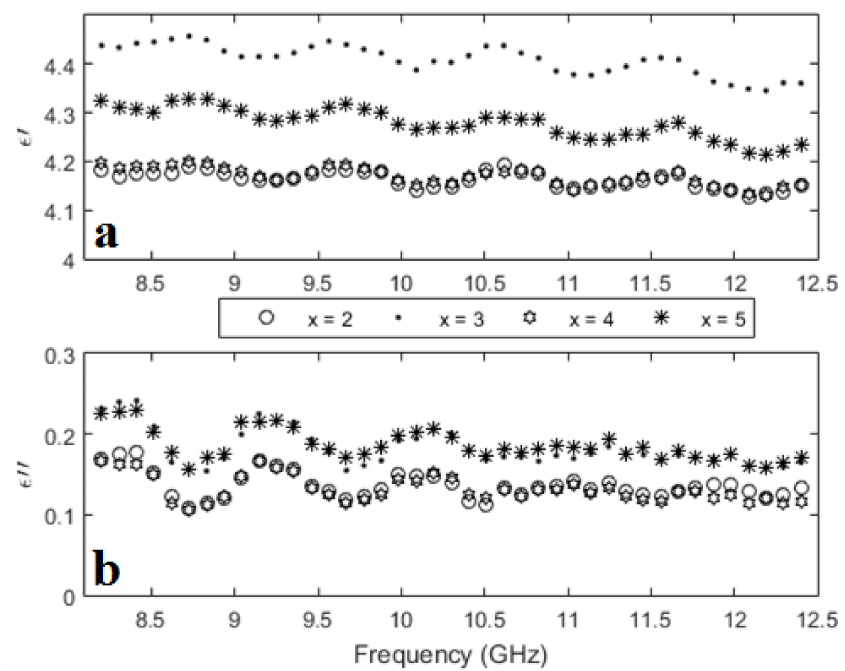
Figure 4. Frequencydependenciesofpermittivity: real(a)andimaginary(b)partsforS r0.3 Ba 0.4 Pb 0.3 Fe 12 O 19 / (CuFe 2 O 4 ) x composite samples (x = 2, 3, 4 and